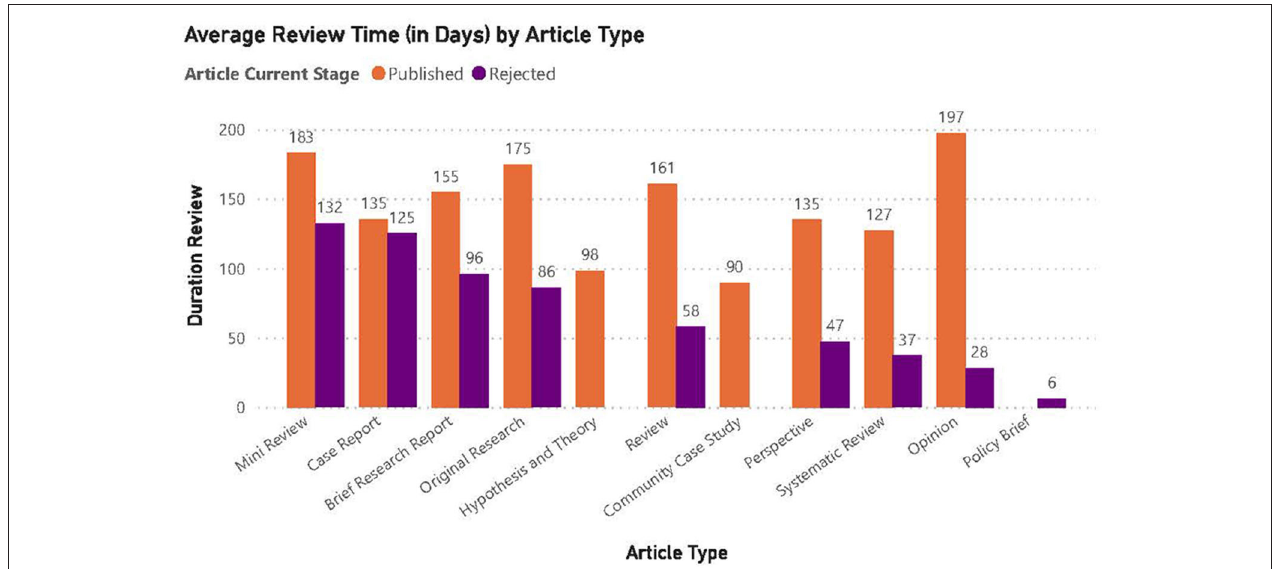
FIGURE 3 | Average review time (in days) by article type. The average review time for manuscripts accepted for publication was 157